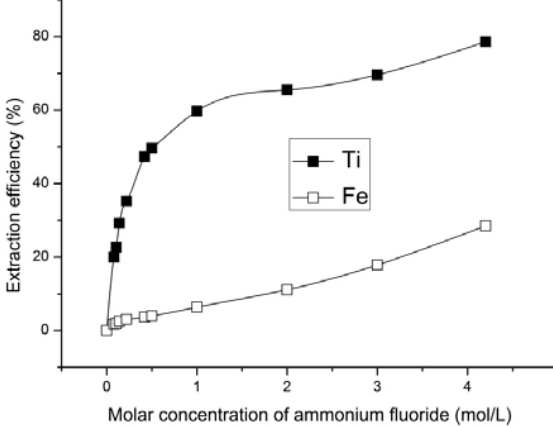
Figure 5. Ti and Fe extraction vs. concentration of ammonium fluoride.